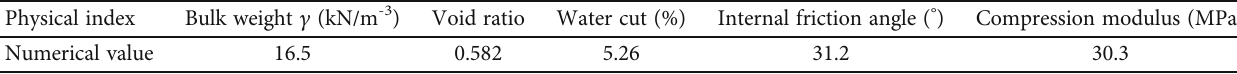
Figure 5: Composition diagram of test device. Table 3: Physical parameters of